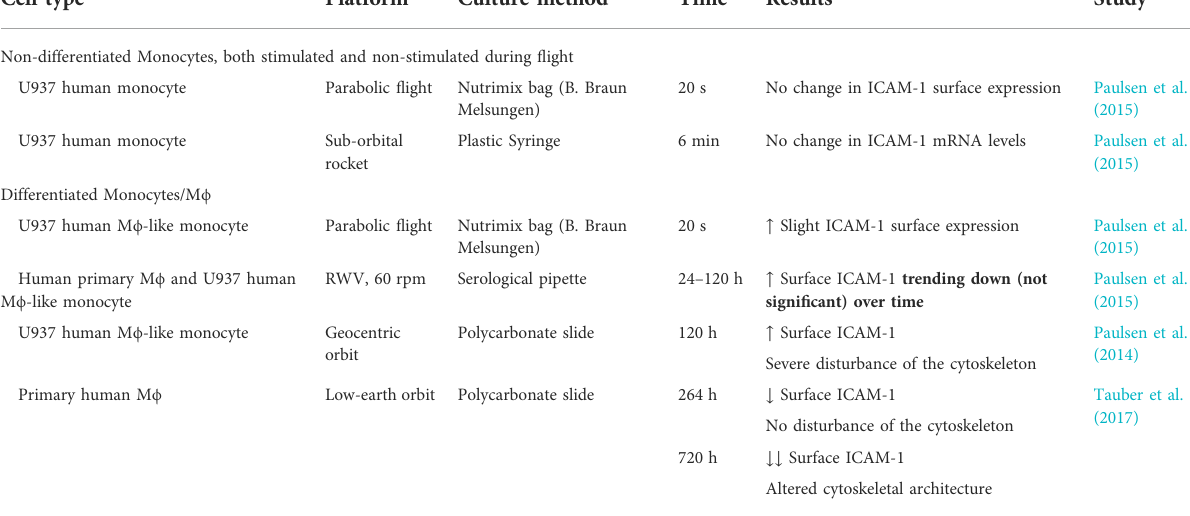
TABLE 3 ICAM-1 surface expression over time in differentiated and non-differentiated M ϕ /monocytes. Simulated and space fl ight microgravity modulated U937 and human M ϕ ICAM-1 surface levels, but did not affect non-differentiated monocytes, even transcriptionally. Note, a microgravity phase of parabolic fl ight lasts 20 s, not enough time for differential transcription, thus differentialsurface expression of ICAM-1 may be attributed to membrane/cytoskeletal dynamics or other post-translational regulatory